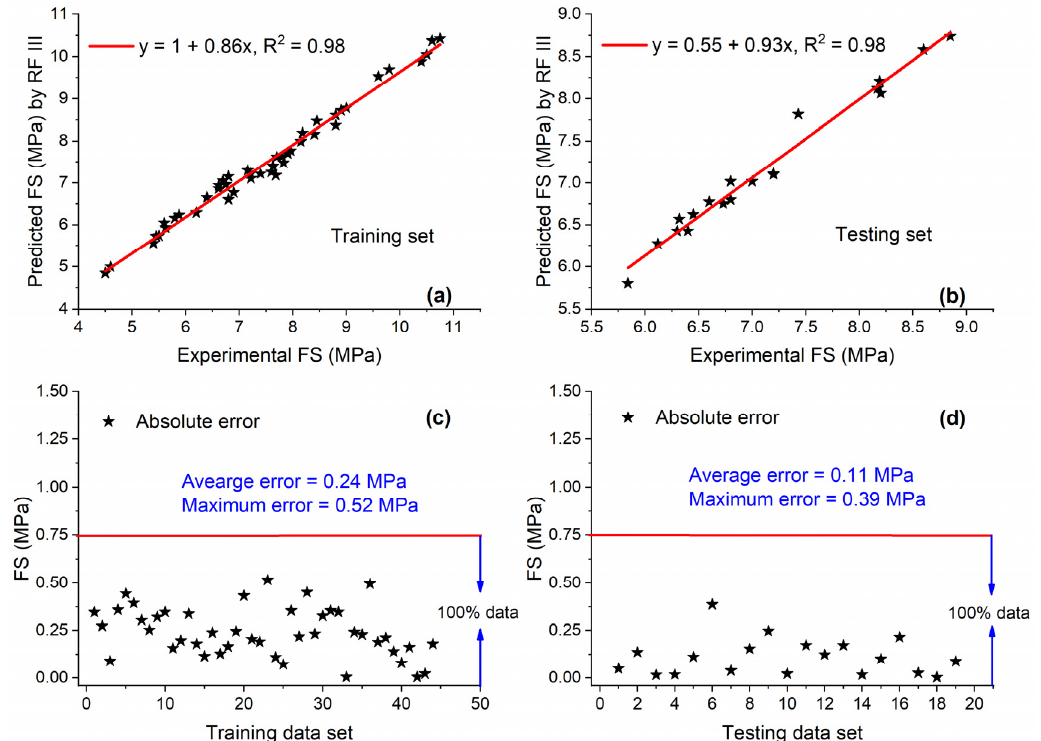
Figure 22. Experimental and predicted values of FS by RF III for ( a ) training set and ( b ) testing set, and their corresponding absolute error for ( c ) training data set and ( d ) testing data set.